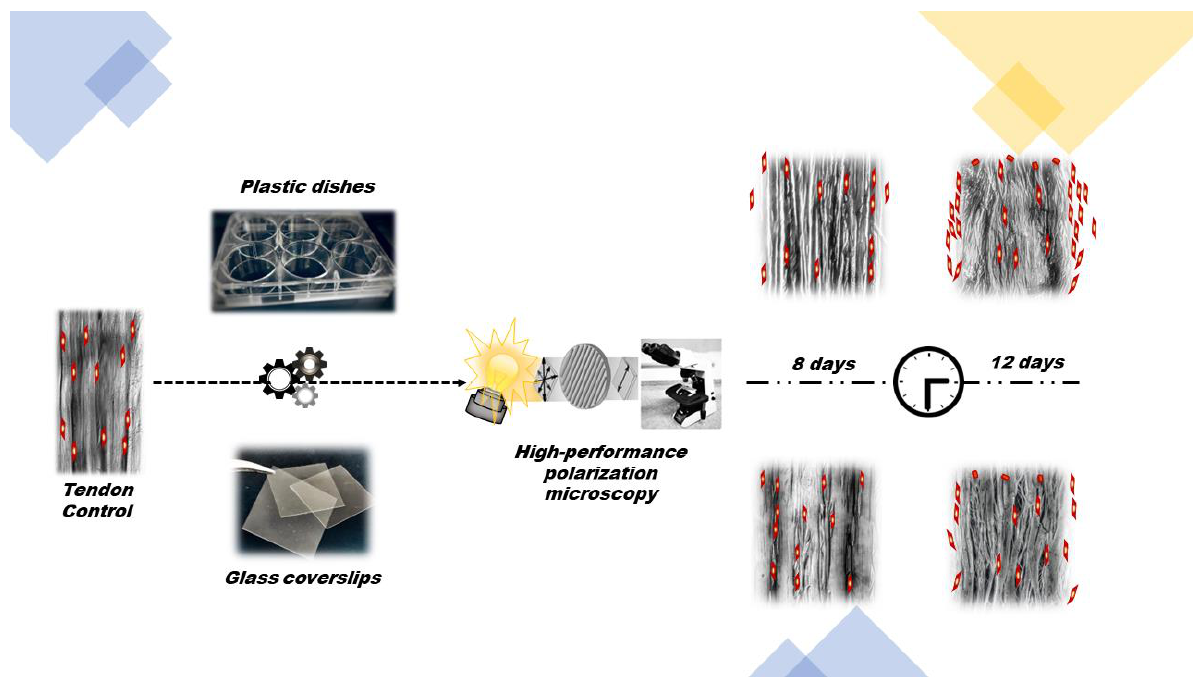
Figure 5. Graphical representation summarizing the main results of the present